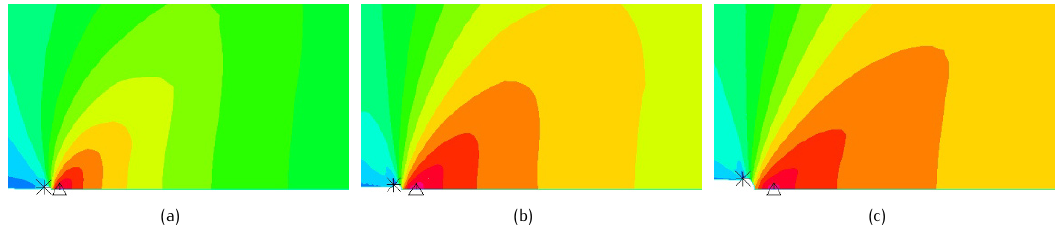
0 = . 2 , σ max /σ . 12 , 0 = 1 0 = 3